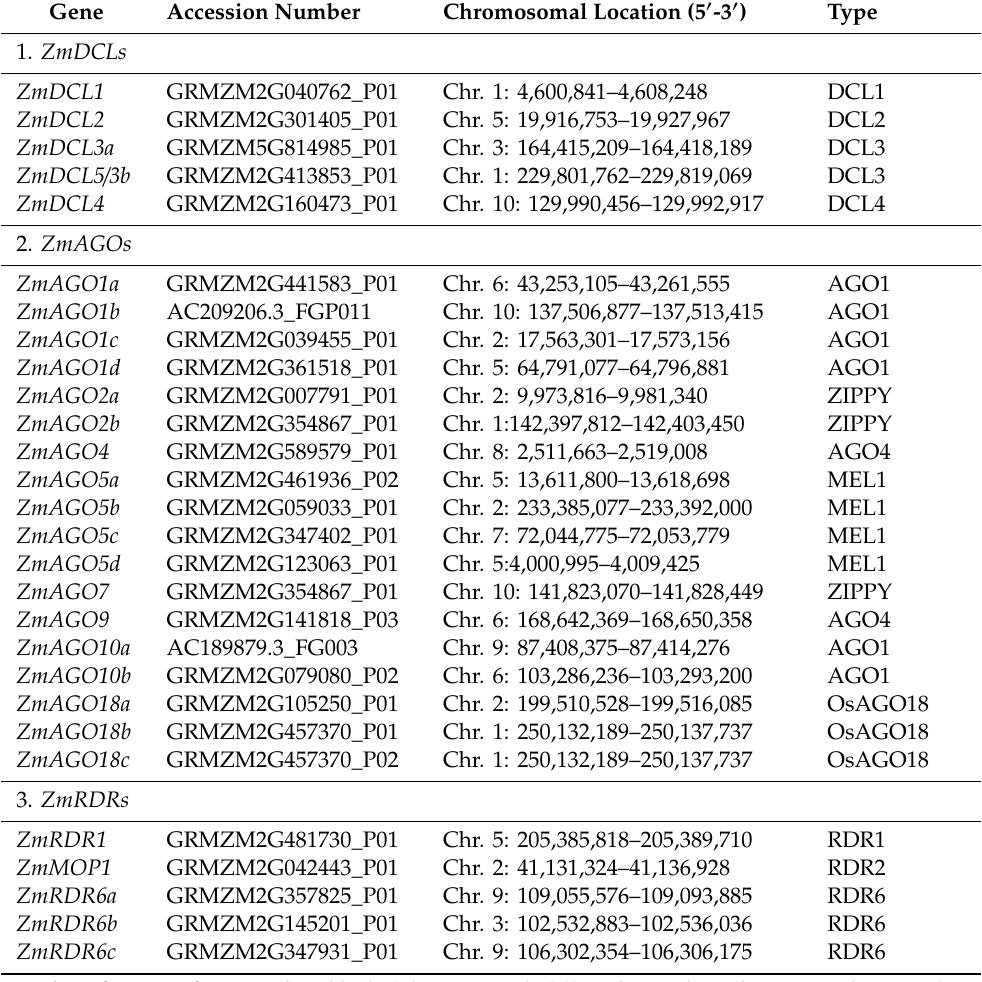
Table 1. Known and putative components of the micro RNA (miRNA) and simple interfering (siRNA) pathways in